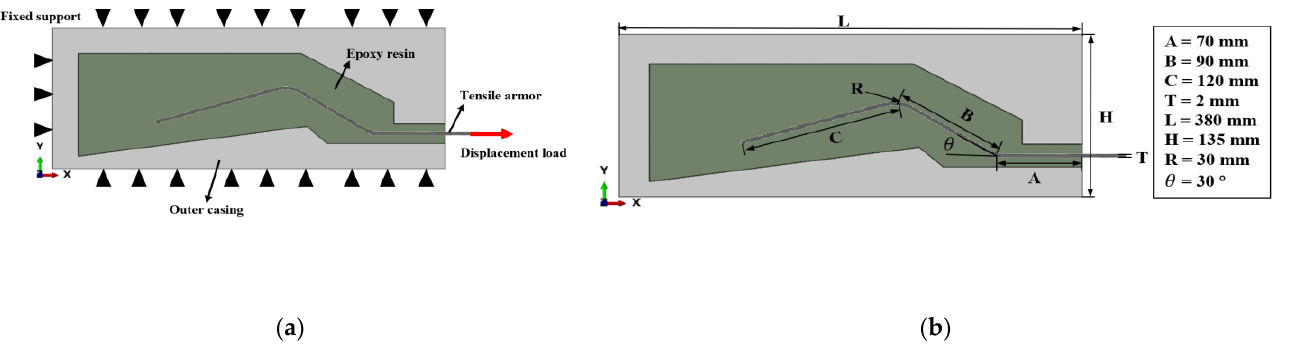
Figure 7. FE Model; ( a ) Model and boundary condition ( b ) Model geometry.